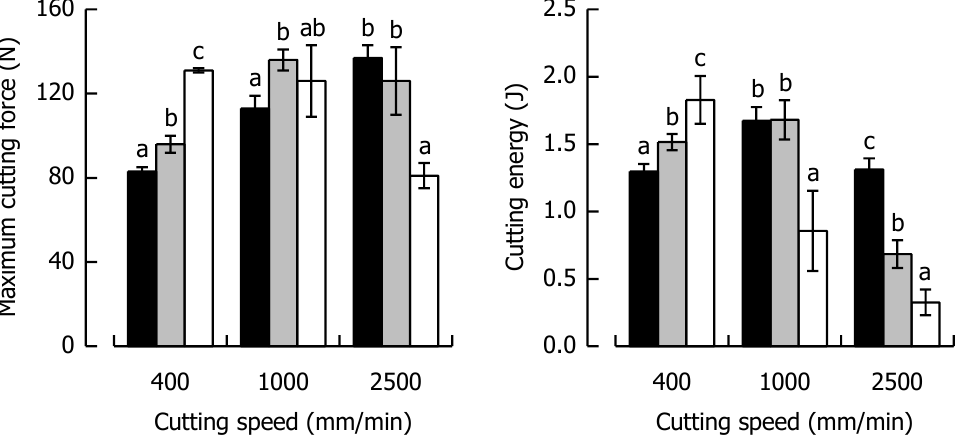
Figure 7. Relationship between maximum cutting force and cutting speed ( left ) and cutting energy and cutting speed ( right ) for the caramels with different solid fat contents. Colors: Formulation SFC1 (black), Ref (grey) and SFC2 (white). Data are arithmetic means ± standard deviation ( n = 4). Different letters in a block indicate significant differences ( p < 0.05).